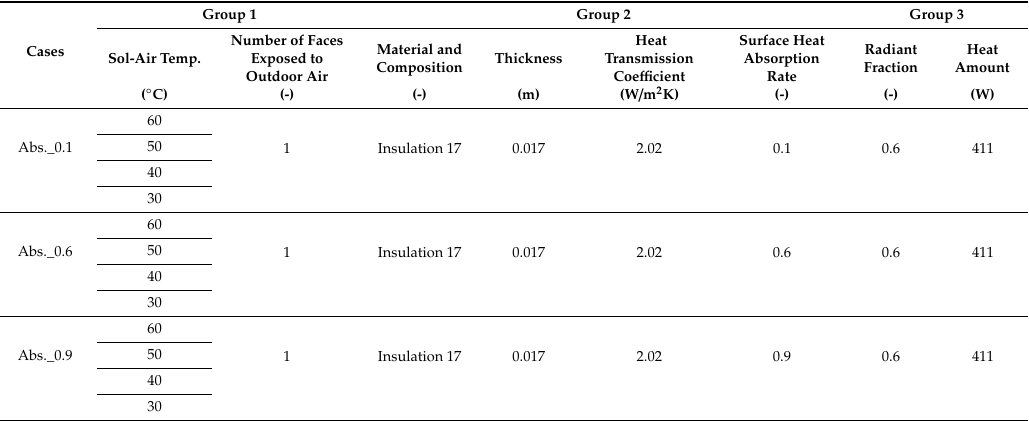
Table 11. Cases for the surface heat absorption rate of the wall.